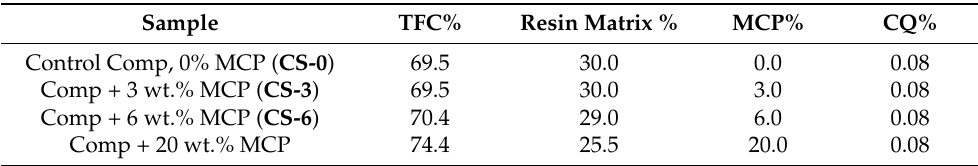
Table 1. Composite